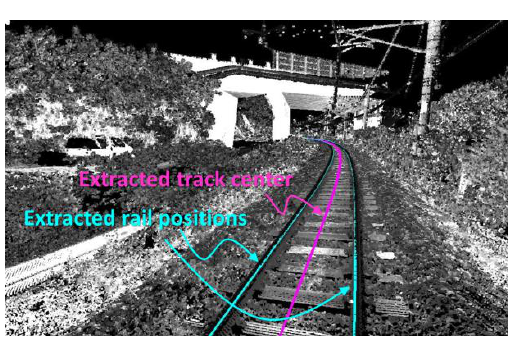
Figure 9. An example of the rail extraction (3-D)